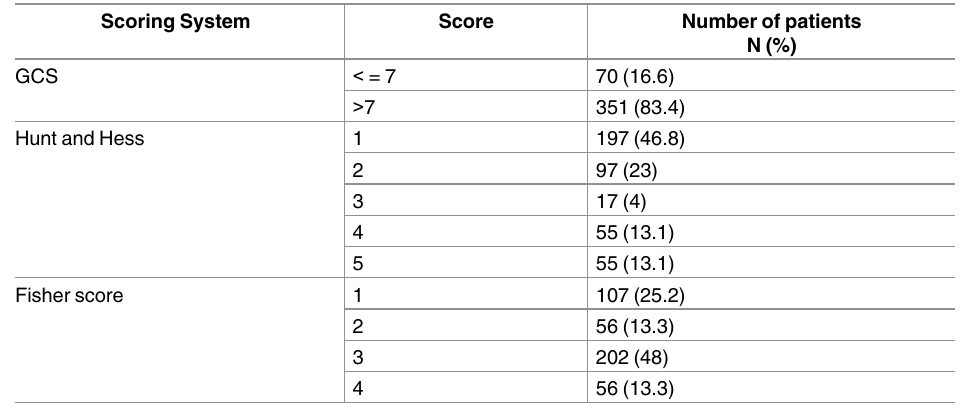
Table 5. Pre-surgery scores of severity.